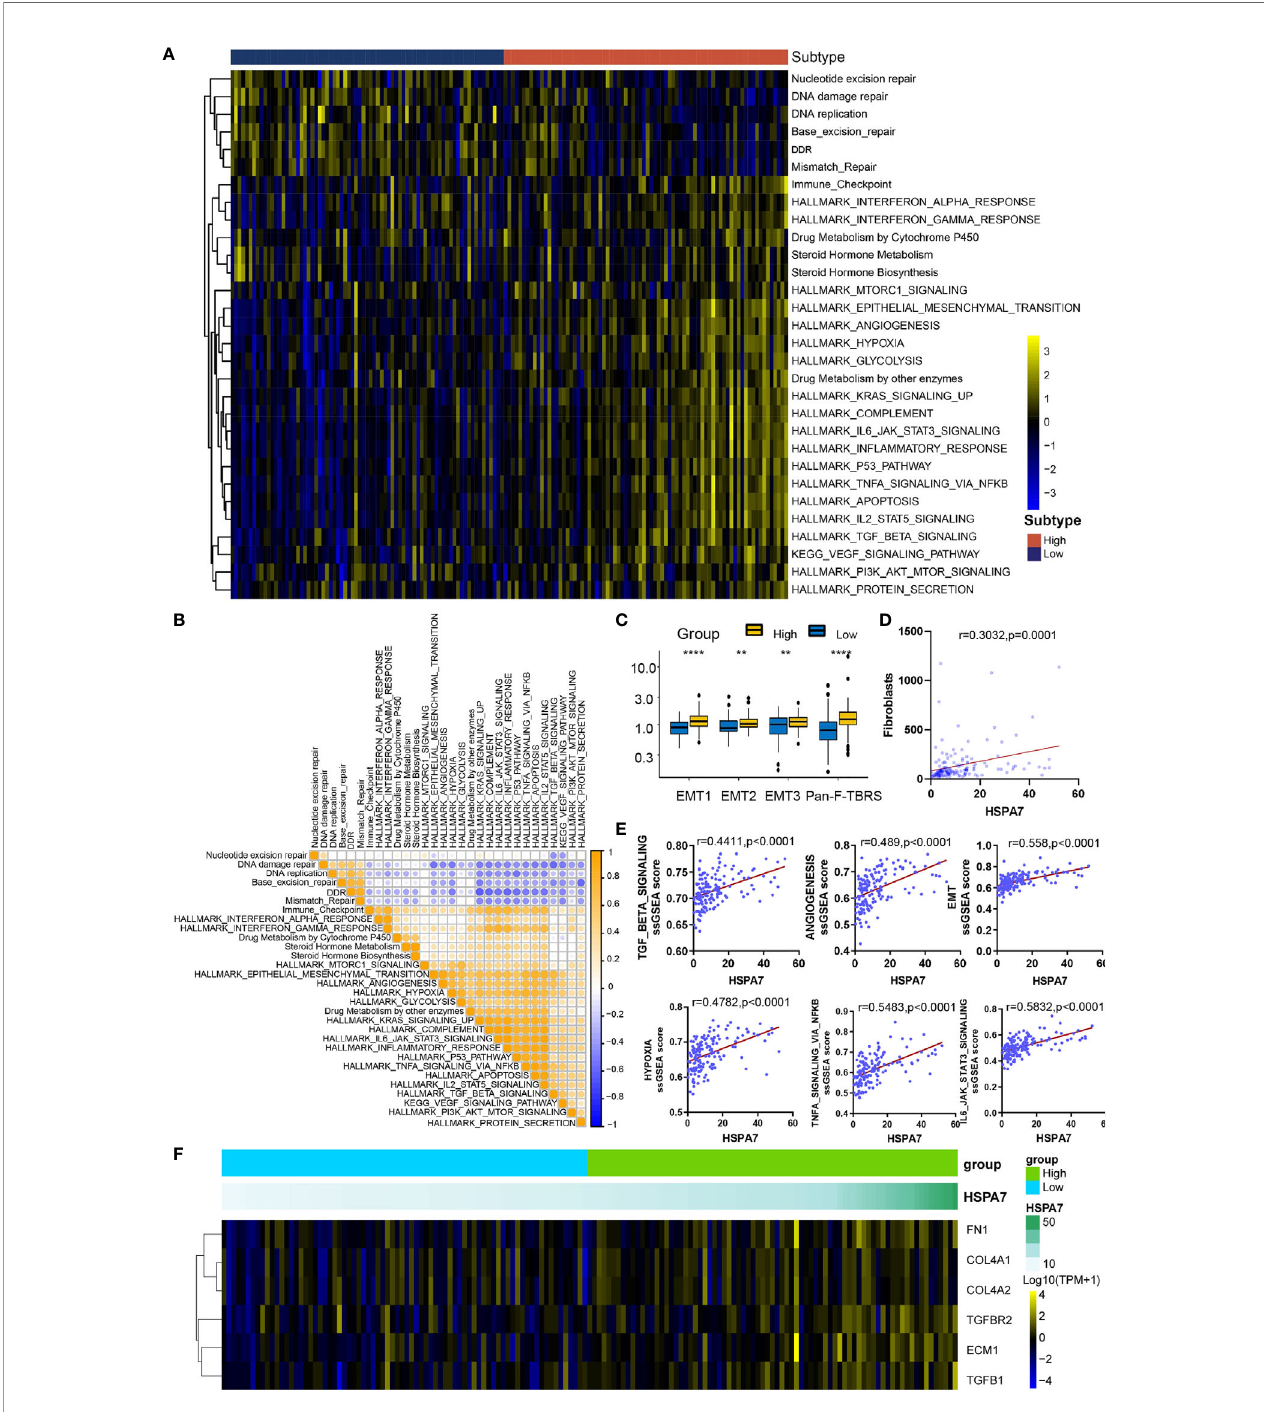
FIGURE 4 | HSPA7 is correlated with stromal and carcinogenic activation pathways. (A) GSVA enrichment analysis showing the activation status of biological pathways in the HSPA7-high and HSPA7-low groups. A heatmap was used to visualize these biological processes. Yellow represents activated pathways, black represents moderately activated pathways, and blue represents inhibited pathways. (B) Correlations between each known gene signature in the TCGA GBM cohort using Pearson correlation analysis. Negative correlations are marked with blue, and positive correlations are marked with orange. (C) Differences in stromal activation-related pathways between the HSPA7-high and HSPA7-low groups. EMT, epithelial – mesenchymal transition; Pan-FTBRS, pan fi broblast TGF- b response signature. (D) HSPA7 expression was positively correlated with fi broblast enrichment, as calculated by MCP-counter. (E) HSPA7 expression was positively correlated with stromal activation-related pathways. (F) A heatmap was used to visualize the expression of stromal activation-related genes. Yellow represents high expression, black represents the median expression, and blue represents low expression. The statistical signi fi cance is shown as: **P < 0.01; ****P <